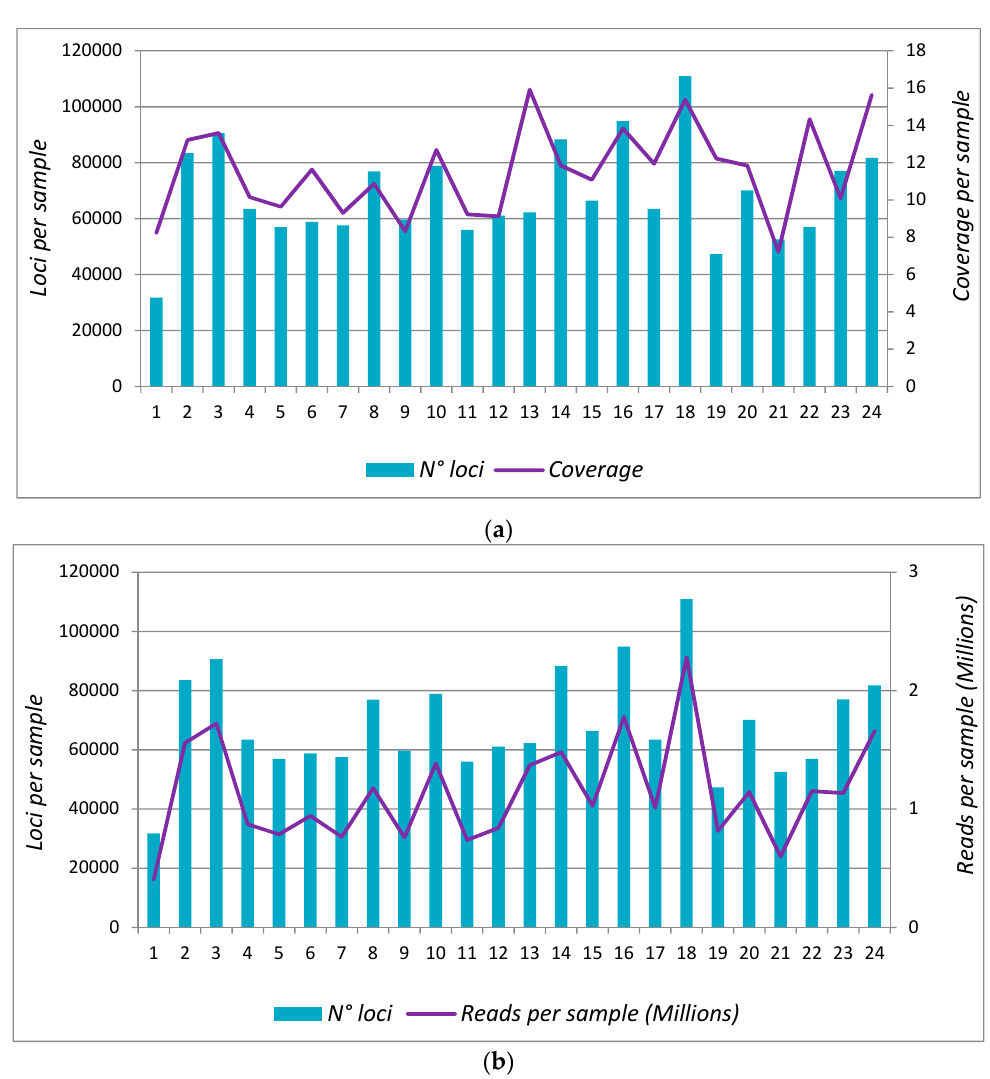
Figure 4. Data of 24 samples sequenced on NextSeq: Number of loci per sample compared with: ( a ) number of reads per sample and ( b ) mean depth of coverage (×) per sample.